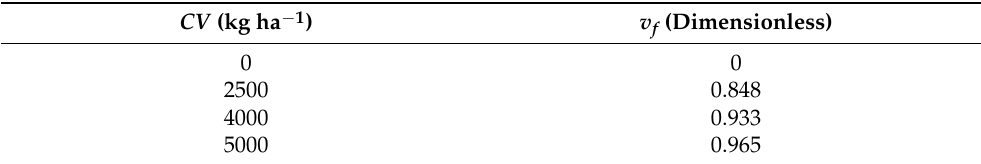
Table 2. Calibrated cover effect factor ( v f ) for total aboveground dry matter biomass ( CV ; based on straw mulch).